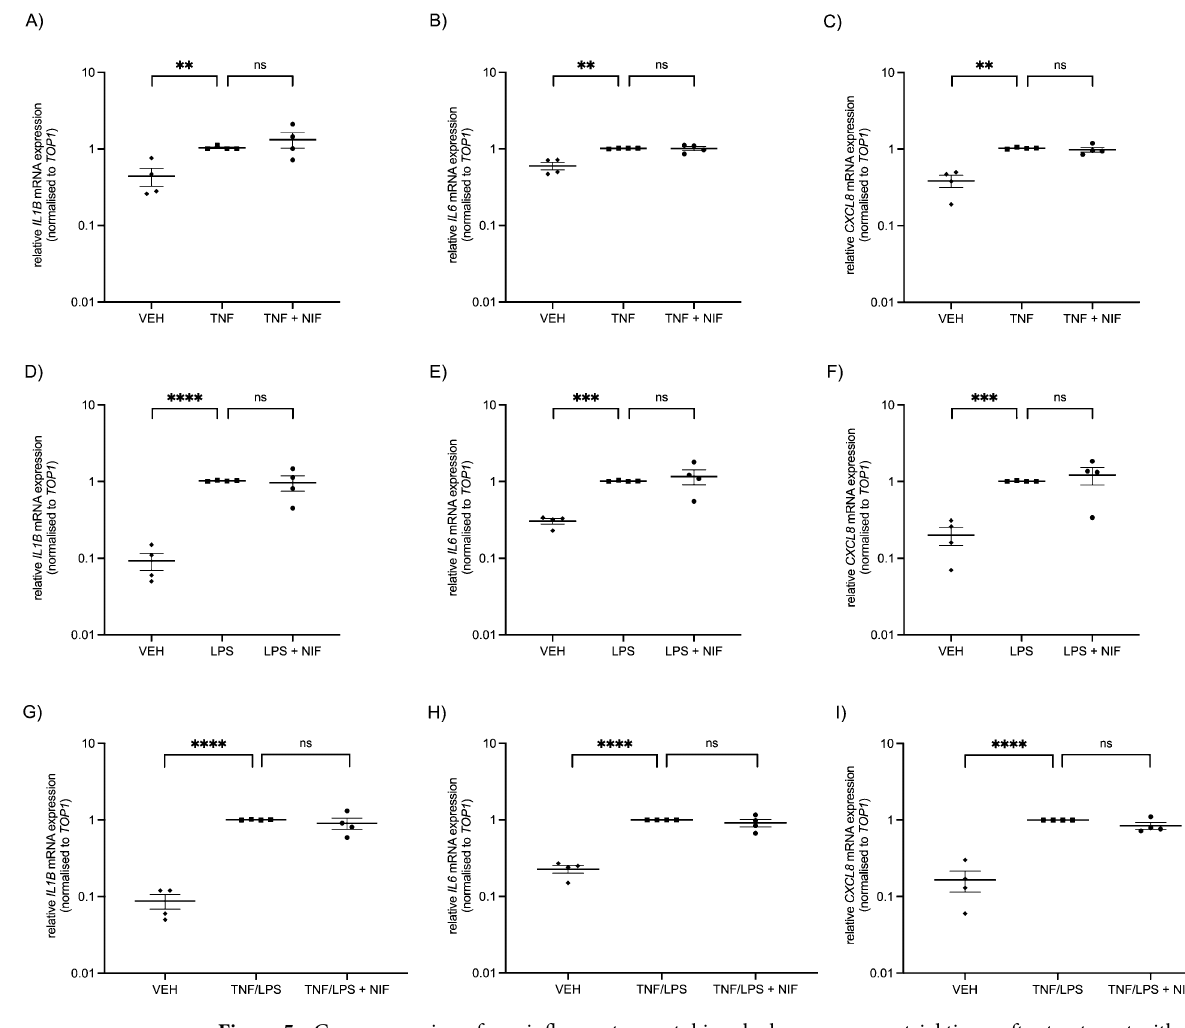
Figure 5. Gene expression of pro-inflammatory cytokines by human myometrial tissue after treatment with vehicle control (VEH), TNF, LPS and nifedipine (NIF). Treatment of myometrial tissue pieces with ( A–C ) TNF (1 ng/ml), ( D–F ) LPS (5 ng/ml) or ( G–I ) concurrent TNF and LPS treatment increases pro-inflammatory mRNA expression of IL-1B , IL-6 , and CXCL8. Addition of nifedipine (10 µM) does not reduce this upregulation. Data are presented as fold change calculated relative to that of TNF-treated tissue ( A–C ), LPS-treated tissue ( D–F ), or combined TNF/LPS-treated tissue ( G–I ). Treatments were performed in duplicate and